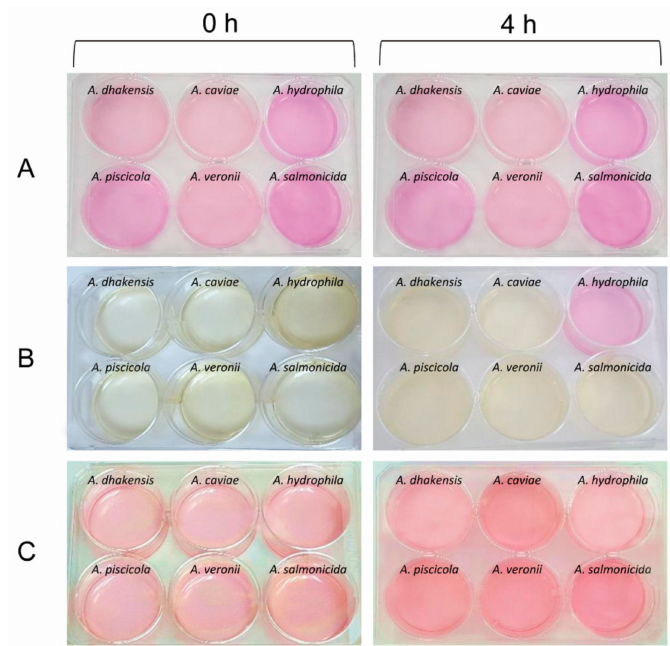
Figure 4. Culture plates with di ff erent Aeromonas species at 0 and 4 h. ( A ) Bacteria culture in alkaline medium DMEM. ( B ) Bacteria culture in acid DMEM with HCl. ( C ) Macrophages in alkaline DMEM infected by di ff erent Aeromonas . Yellow indicates acid pH and pink indicates alkaline